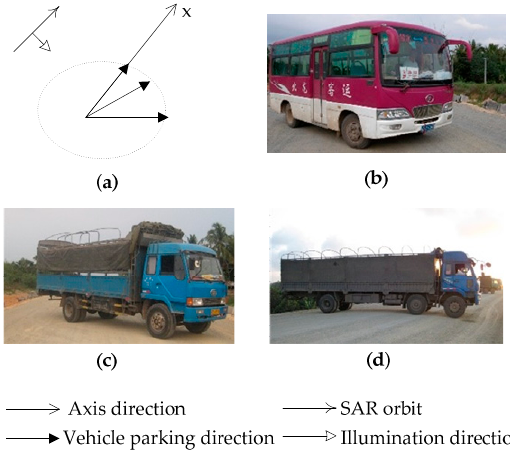
Figure 2. Vehicle deployment at three predetermined aspect angles in Experiment I: ( a ) the relationship between SAR and three predetermined aspect angles; ( b ) medium bus; ( c ) medium truck, and ( d ) larger truck.